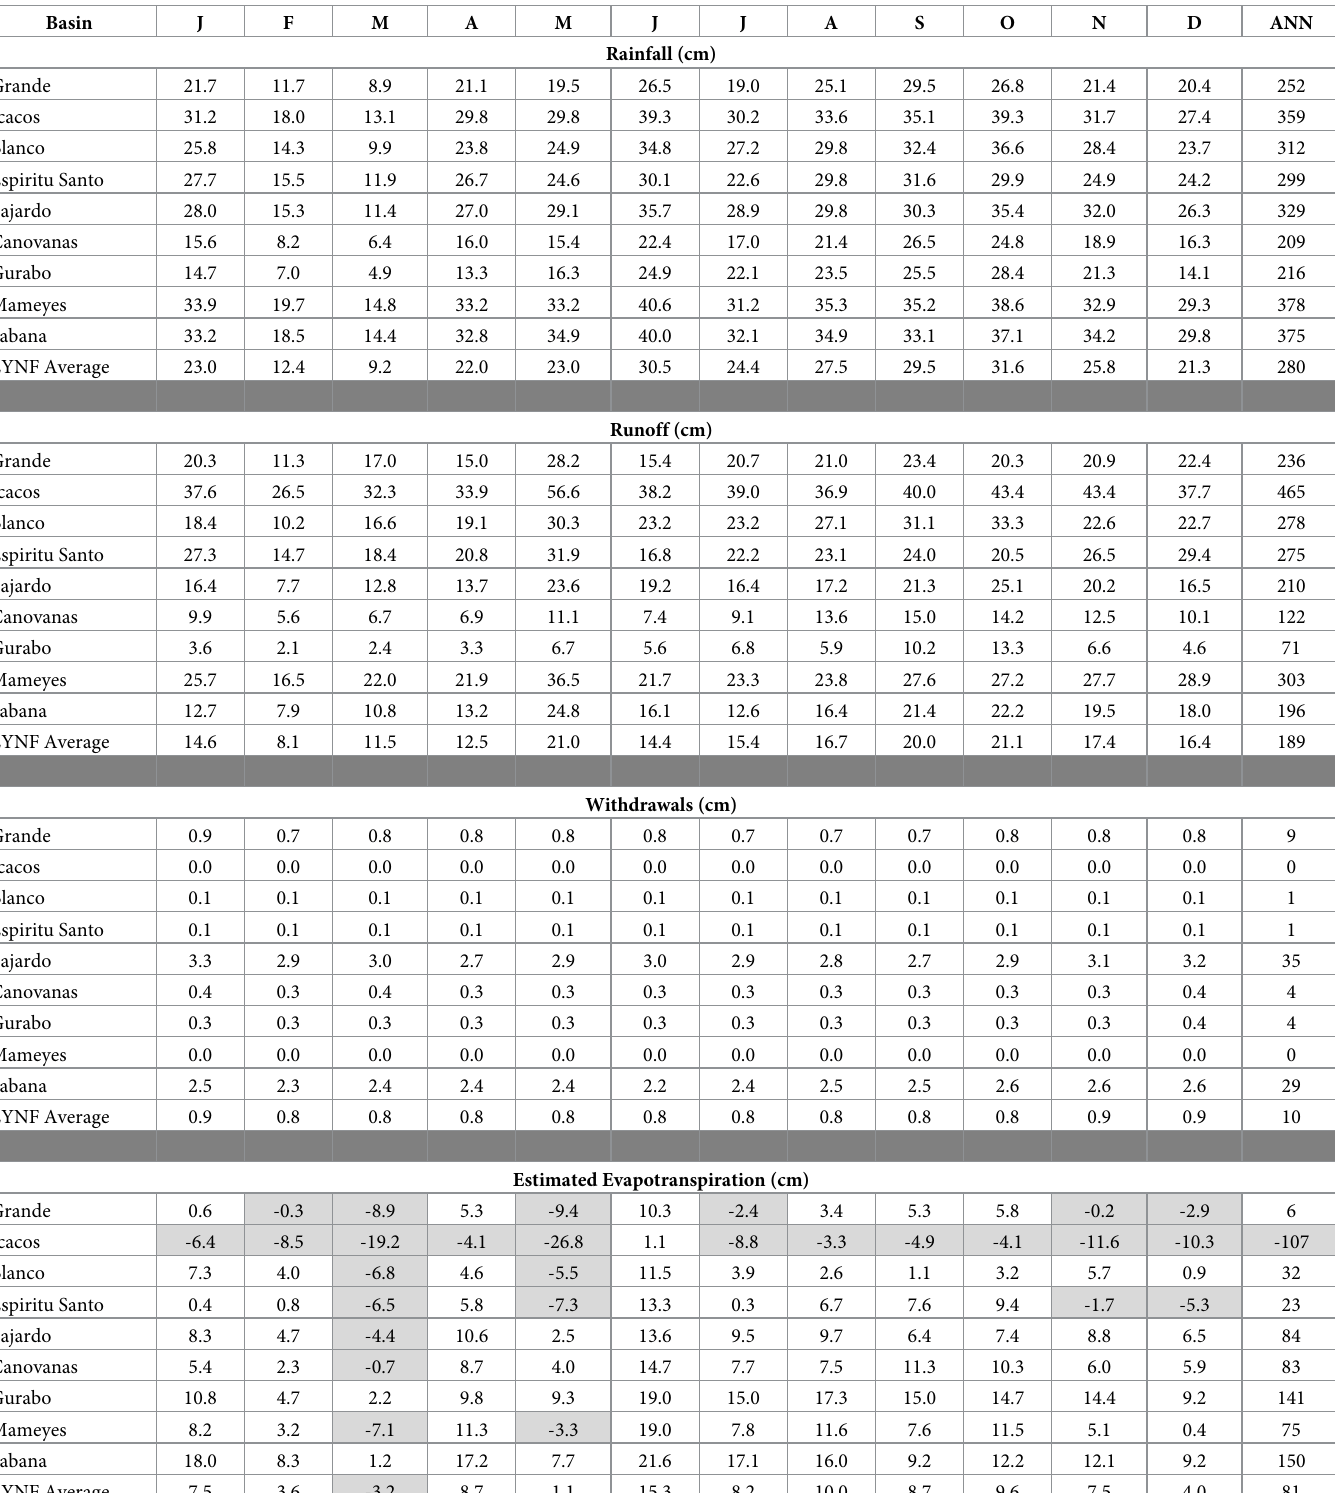
Table 2. Summary of hydrologic budget for the EYNF. All values are expressed as depth in centimeters and presented as monthly and annual totals. Forest-wide aver- ages are expressed as area-weighted quantities for the nine focal watersheds. Several instances occur where runoff and withdrawals exceeded precipitation, leading to nega- tive ET values. All negative ET values are highlighted using gray shading. Basin J